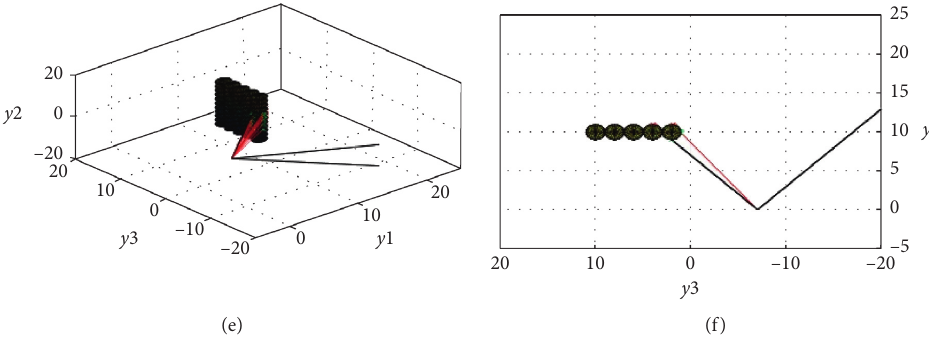
Figure 33: Simulating the work of CVS: ( a ) 3D view of AMR no. 1; (b) plan view of AMR no. 1; (c) 3D view of AMR no. 2; (d) plan view of AMR no. 2; (e) 3D view of AMR no. 3; (f) plan view of AMR no. 3.